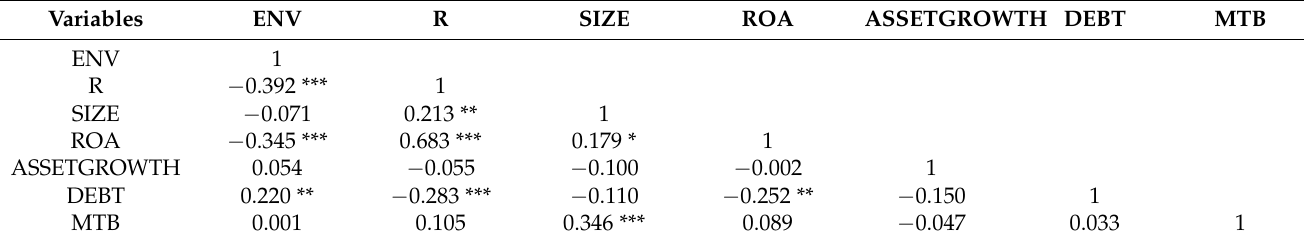
Table 3. Correlations